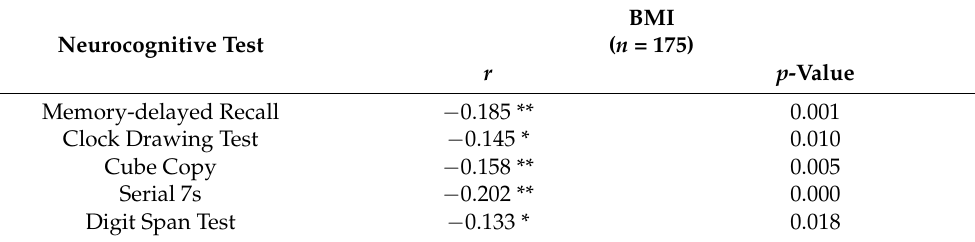
Table 2. Association between body mass index and neurocognitive test performance.